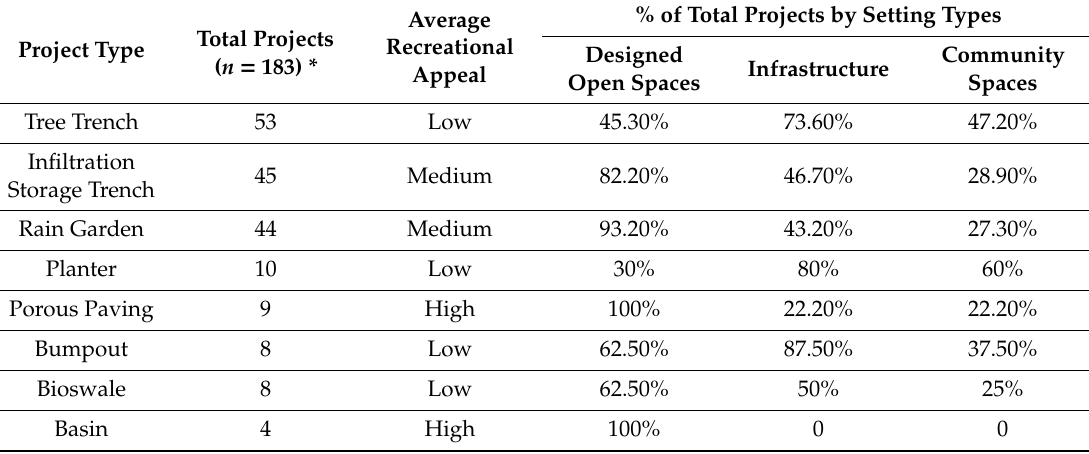
Table 2. Philadelphia GSI Recreational Appeal and Project Setting.